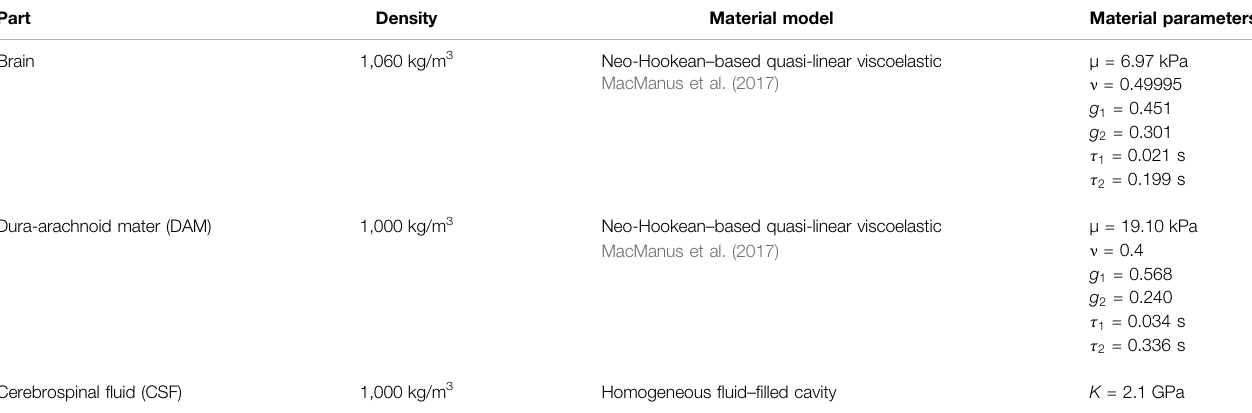
TABLE 2 | Material properties used in the FE model of the porcine brain FE. Part